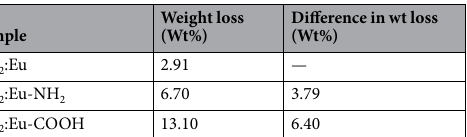
Table 1. The weight loss percentages calculated from TGA for SiO 2 :Eu, SiO 2 :Eu-NH 2 and SiO 2 :Eu-COOH functionalized